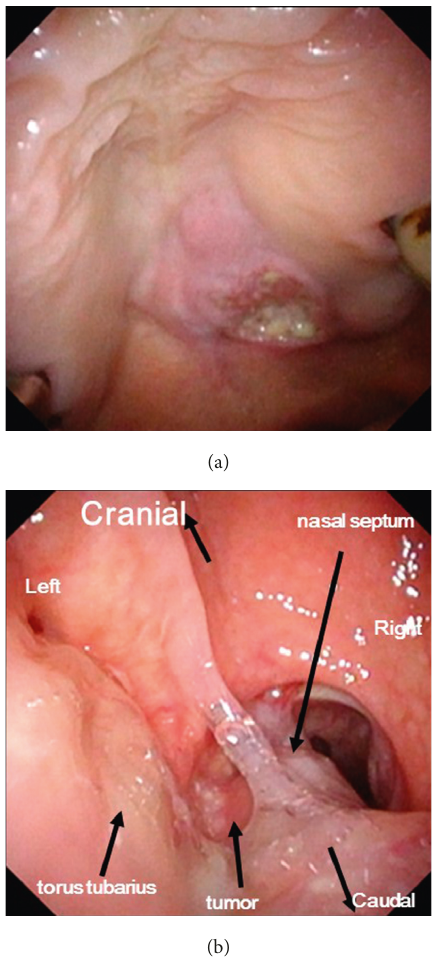
Figure 1: (a) Oral view of the palatal tumor. (b) Posterior nasal aperture view. Fiberscope was inserted from mouth and turned to posterior nasal aperture via uvula. Fiberscope tip was turned upside down, and posterior nasal aperture view was taken. Tumor can be seen in the left posterior nasal meatus area and is clearly invading the nasal septum. Right torus tubarius is intact.